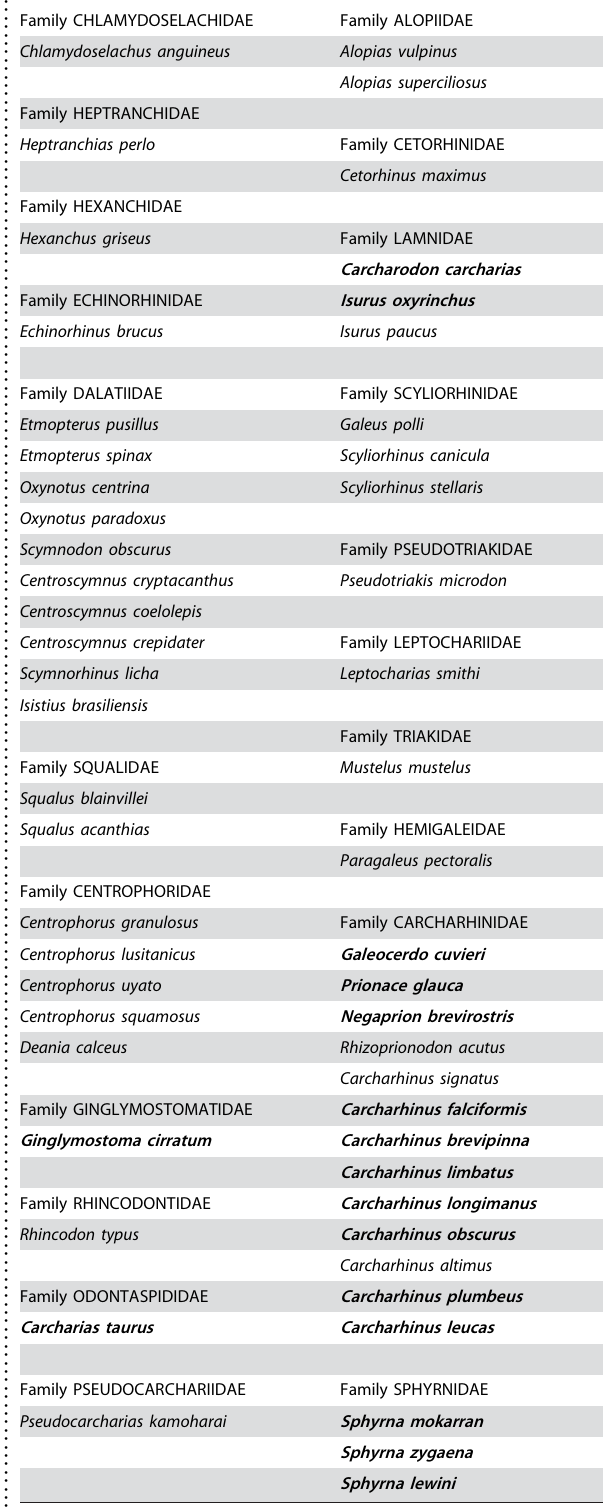
Table 1. List of sharks known from the Senegalese coasts. Species implicated in attacks around the world are indicated in bold (compiled data from references [2,3,4,7,19,20]). ... ... ... .... ... ... .... ... ... .... ... ... .... ... ... .... ... ... .... ... ...